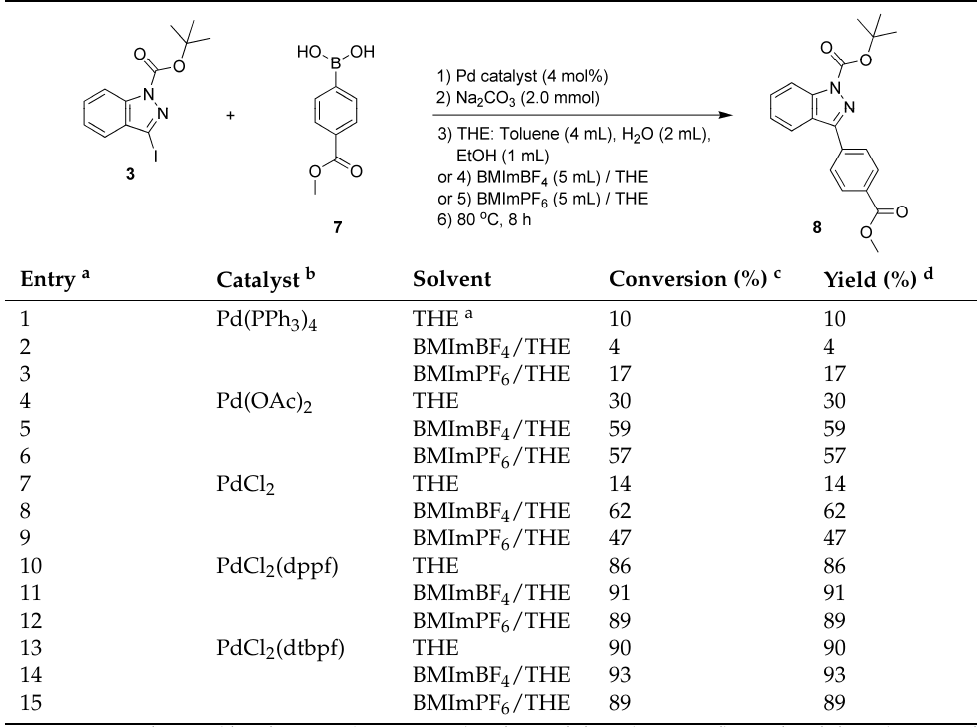
Table 2. Catalytic Suzuki–Miyaura cross-coupling of compounds 3 with 7 .